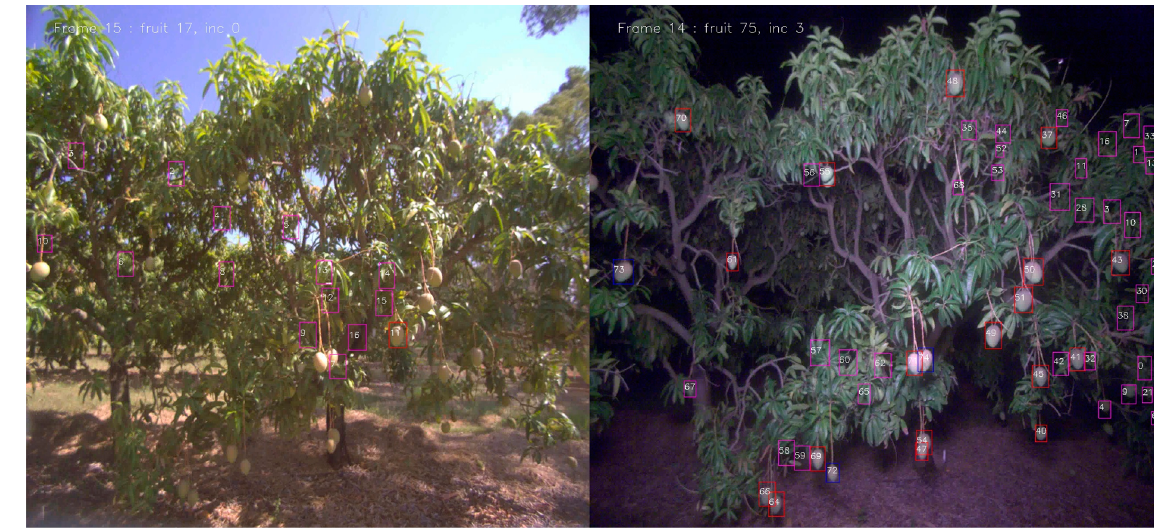
Figure 6. Image of the same mango tree canopy at day and at night. Bounding boxes relate to tracking of fruit between frames.